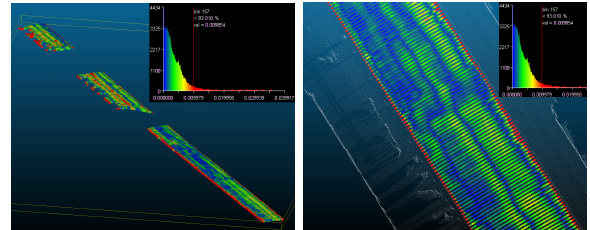
Figure 11: Maps and histograms of the distances between the pro- duced surface model and the real ground points on a road section.